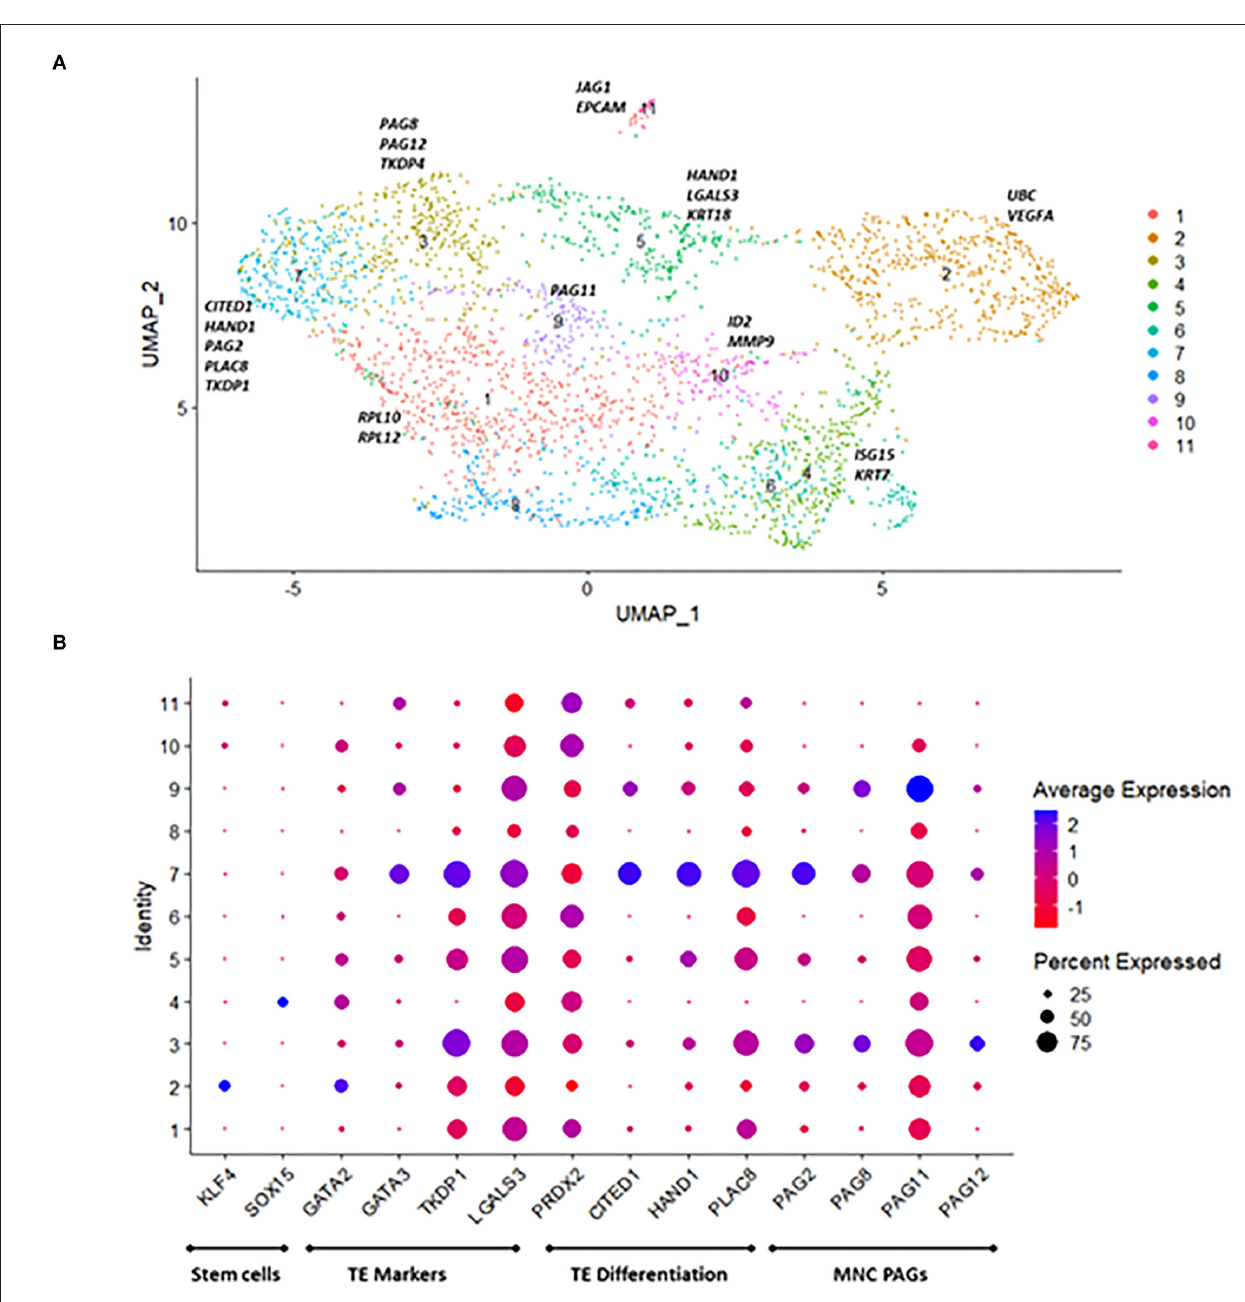
2015). The fact that several markers ( Figure 5 ) are present in various clusters with different levels of expression could indicate some transition in the function of the cells in these